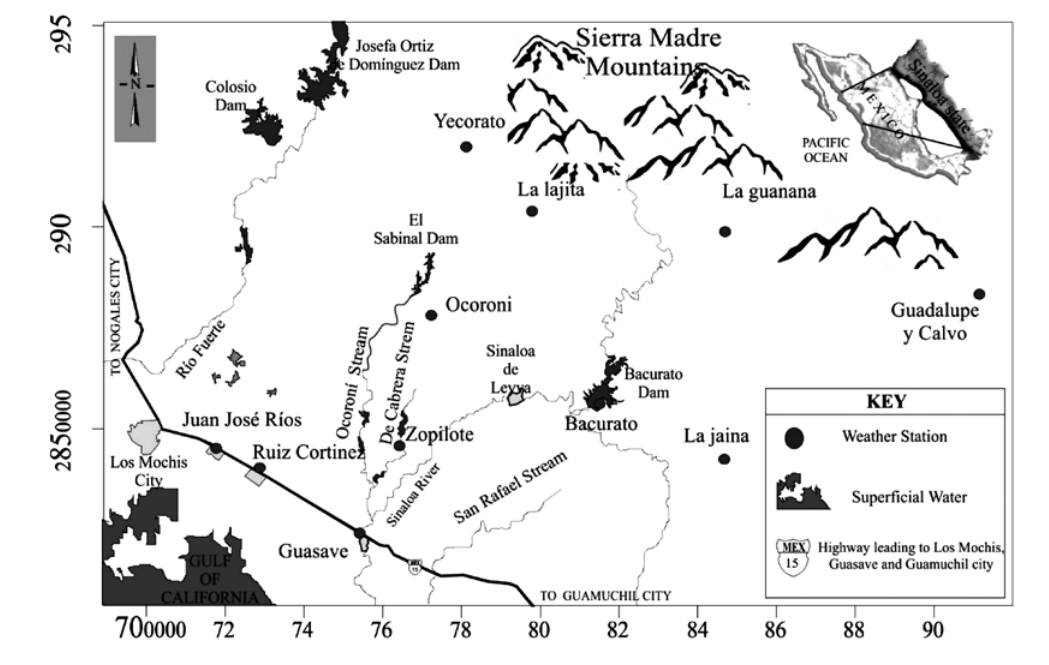
Fig. 1. Location of study